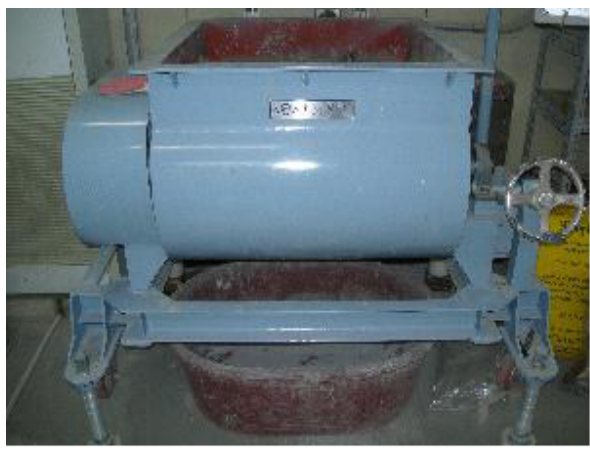
Figure 1. Two-shaft twin